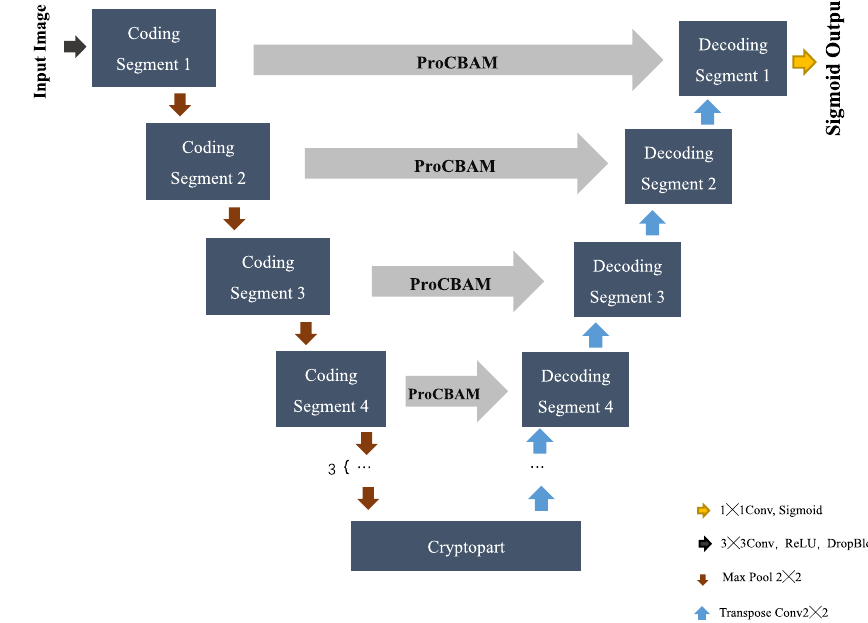
Fig. 6 The proposed DU-Net network